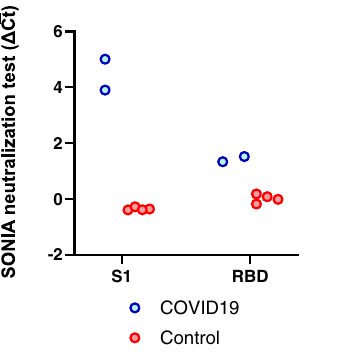
Fig. 2 Selection of antigens for the SONIA neutralization PCR test. Both S1 subunit and receptor binding domain (RBD) of spike protein have the ability to engage with the ACE2. To evaluate suitability for the neutralization PCR assay, we tested convalescent COVID-19 patient sera ( N = 2, blue circle) and healthy donor sera ( N = 4, red circle) collected prior to the outbreak. The COVID-19 sera were con fi rmed to harbor NAb by a pseudo-virus neutralization assay. The y-axis is the SONIA neutralization PCR test signal Δ Ct calculated by subtracting the Ct value of the sample from that of a buffer only blank control.